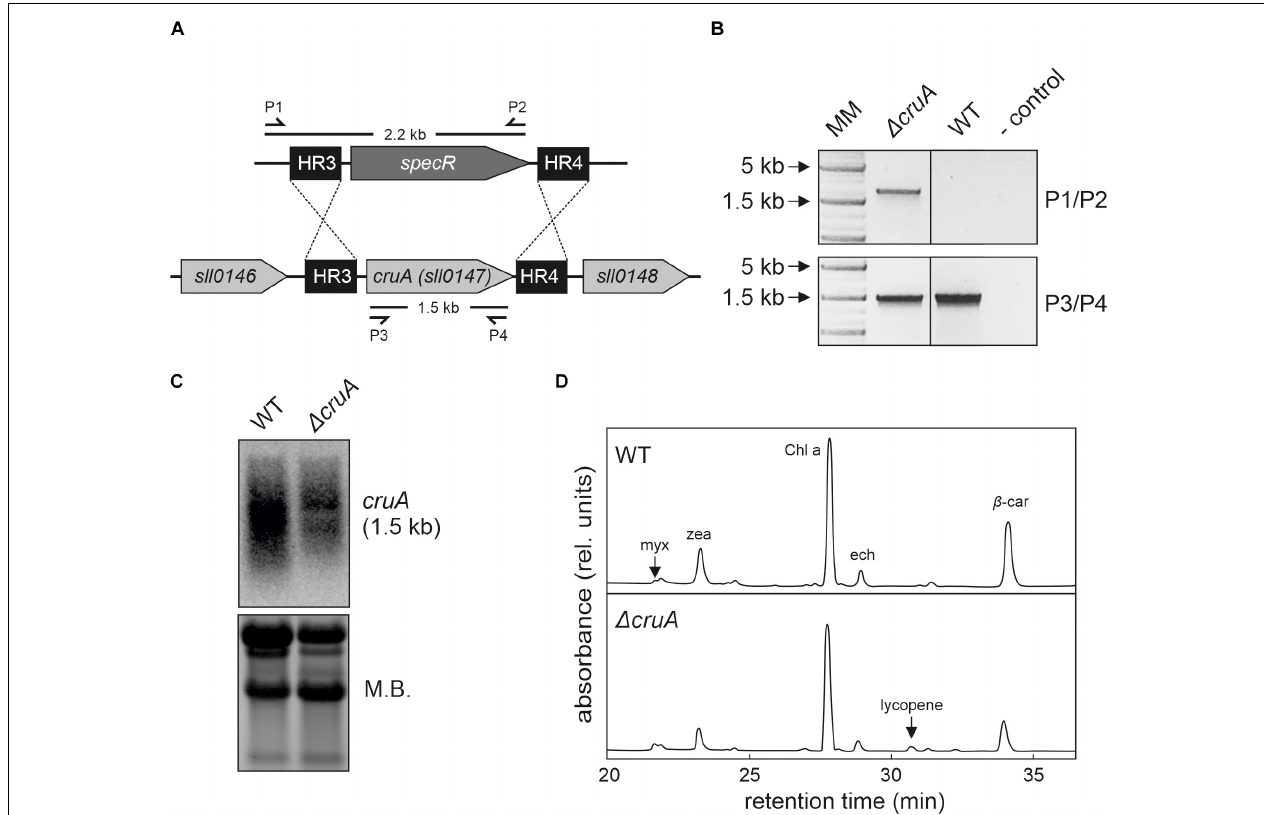
FIGURE 3 | Isolation of the (cid:49) cruA knockdown strain. (A) Design of the cruA insertion cassette. A spectinomycin resistance-mediating gene was inserted between two sequences (HR3 and HR4) designed to mediate the deletion of the complete cruA coding sequence ( sll0147 ). (B) Characterization of the (cid:49) cruA knockdown strain and the segregation status by PCR analyses. Primer-binding sites and product lengths are shown in panel (A) . P1–P4: primers (see Supplementary Table 3 for further information), MM: molecular marker. Full-length gel of panel (B) is presented in the Supplementary Figure 2A . (C) RNA gel-blot hybridization analyses with total RNA isolated from wild type (WT) and (cid:49) cruA . After fractionation on a denaturing RNA gel and transfer to a nylon membrane, cruA transcripts were identified with radioactively labeled [ α − 32 P]dCTP DNA probes. Equal loading was checked by staining the nylon membranes with methylene blue solution (M.B.). Full-length blots of panel (C) are presented in the Supplementary Figure 2B . (D) HPLC analysis of WT and the two (cid:49) cruA mutants grown under low-light conditions (30 µ mol photons m – 2 s – 1 ). Major pigments and lycopene (peak at retention time 30.25 min in the (cid:49) cruA sample) are indicated. myx: